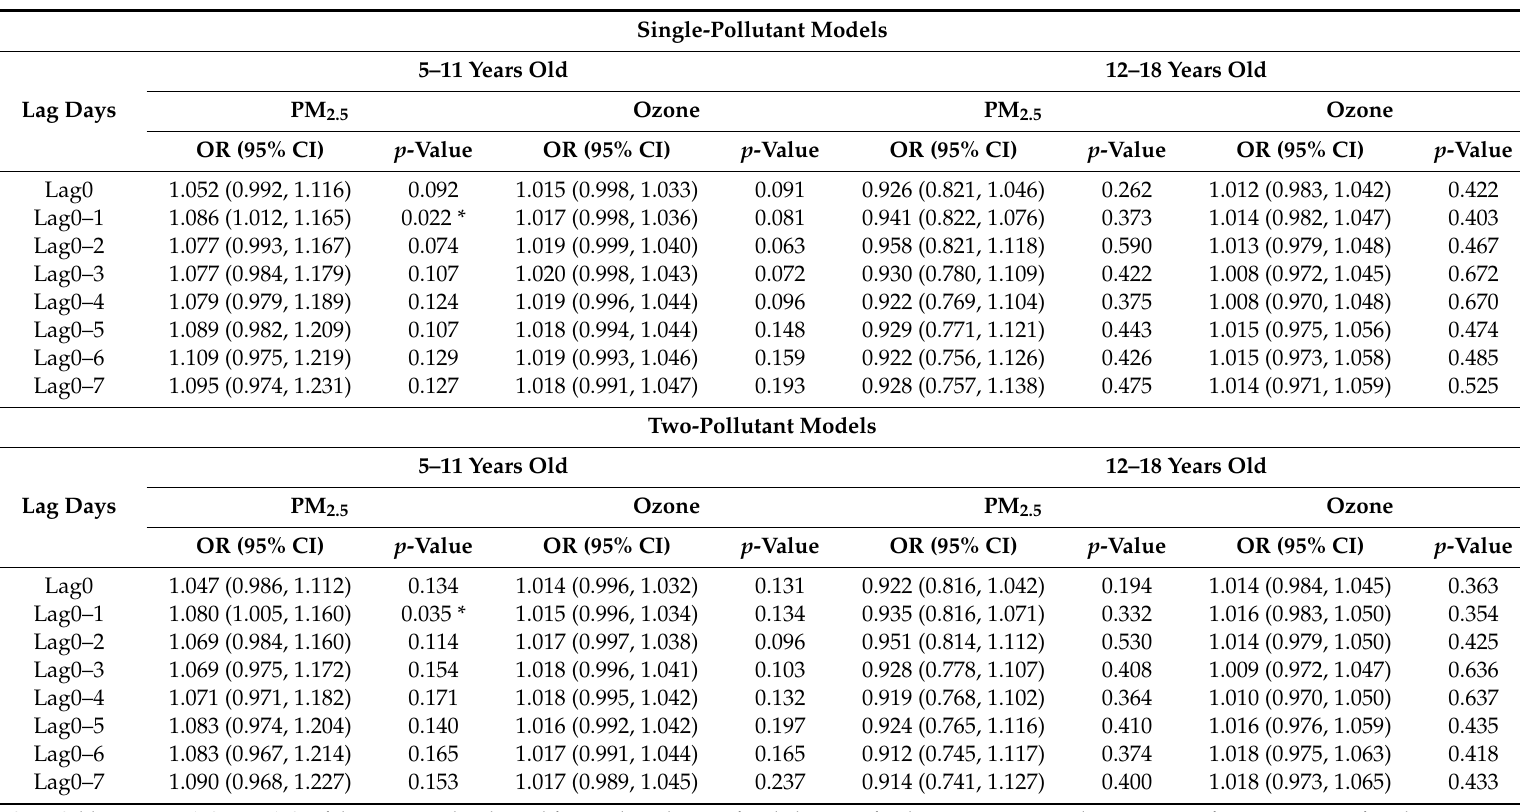
Table 4. Results of multivariate binomial logistic regression analysis stratified by age in single- and two-pollutant